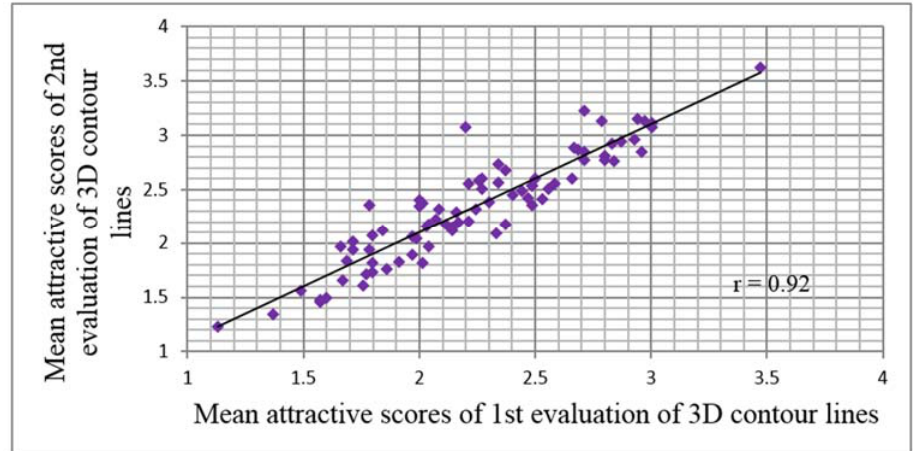
Figure 2. Scatter diagram of correlation between 1st and 2nd evaluation of 3D contour lines within two week interval (Pearson’s correlation, r = 0.92).